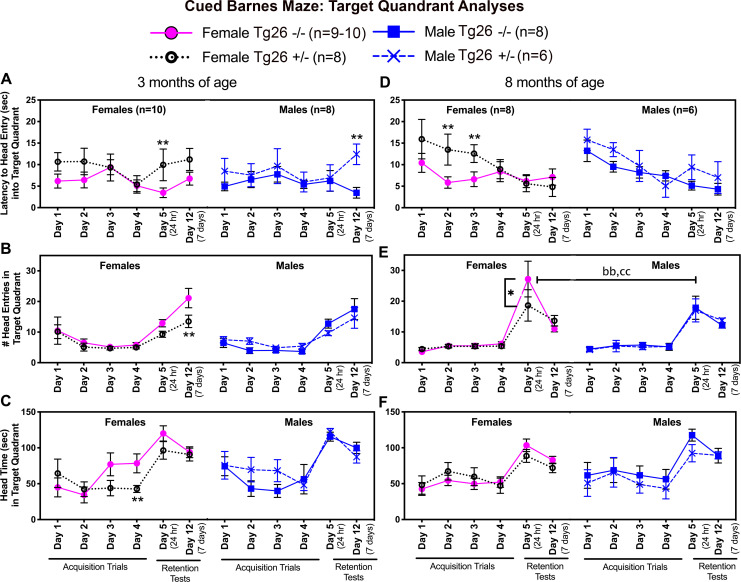
Barnes maze target quadrant results.Assessment of memory abilities on a Barnes maze at 3 and 8 months of age, during target quadrant analyses of four acquisition days (Days 1–4 of Barnes maze testing) and at two retention probe test points (24 hours and 7 days after completion of acquisition training, which are Days 5 and 12 of Barnes maze testing). (A and D) Latency to first head entry into the target quadrant at 3 and 8 months of age, respectively. (B and E) Number (#) of head entries into target quadrant at 3 and 8 months of age, respectively. (C and F) Head time in target quadrant at 3 and 8 months of age, respectively. Mean ± SEM shown. *:p<0.05 and **: p<0.01, compared to wild type -/- mice of same sex. bb: p<0.01, compared to opposite sex of same genotype (opposite sex). cc: p<0.01, compared to opposite sex of opposite genotype (opposite sex and genotype). For ease of reading, mix-model effects findings are indicated in the text. Numbers/group: At 3 months of age, there were 10 female wild type -/- mice, 8 female Tg26 +/- mice, 8 male wild type -/- and 6 male Tg26 +/- mice. At 8 months of age, there were 9–10 female wild type -/- mice, 8 female Tg26 +/- mice, 8 male wild type -/- and 6 male Tg26 +/- mice.